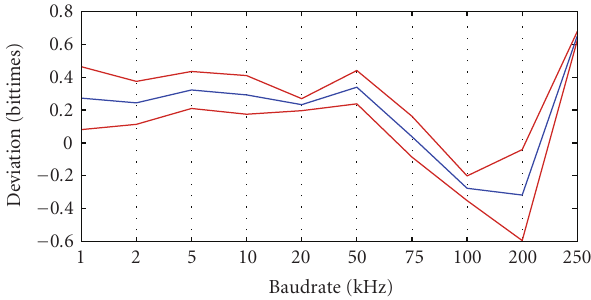
Figure 15: Mean relative deviation from optimal sending point versus baud rate.